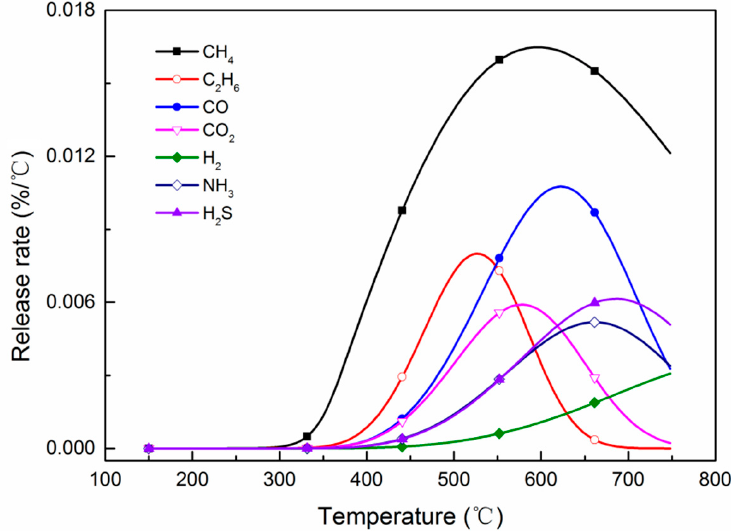
Figure 5. Release rate of other seven volatile components excluding tar and H 2 O from the coal particle ( d = 20 mm). Table 5. The temperature corresponding to peak release rate of volatile components.